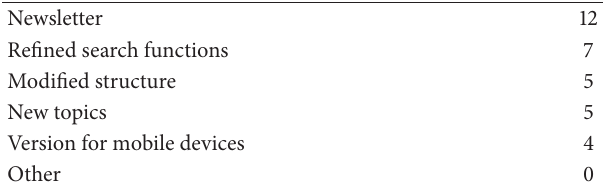
Table 1: Feedback from rehabilitation centers regarding potential website